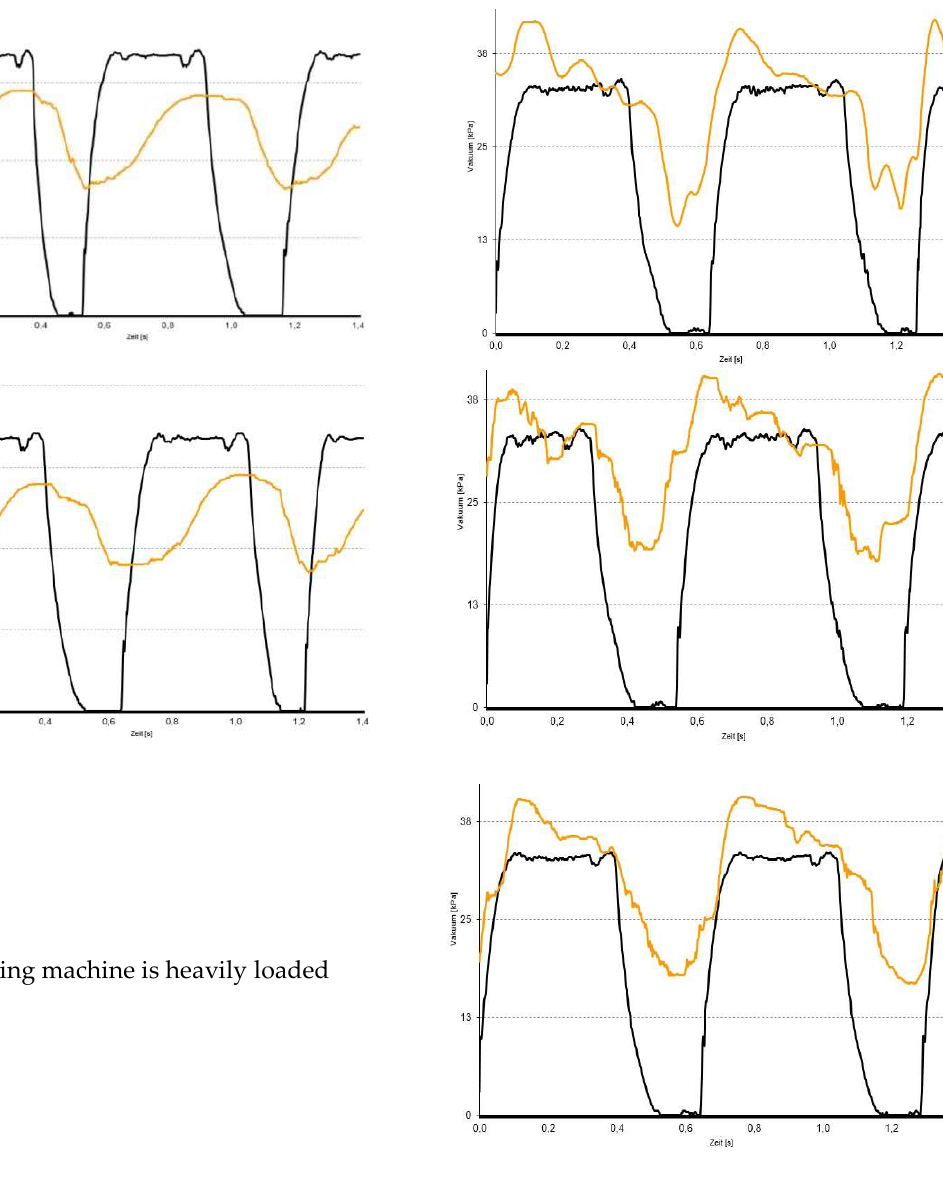
Figure 5. Cyclical vacuum fluctuations in the pulsation and inner chambers of the teat cup during the 1st WF in the goat milking machine, with the following settings: 34 vacuum level (kPa), 90 pulsation rate (cycles/min) and 60:40 pulsation ratio.